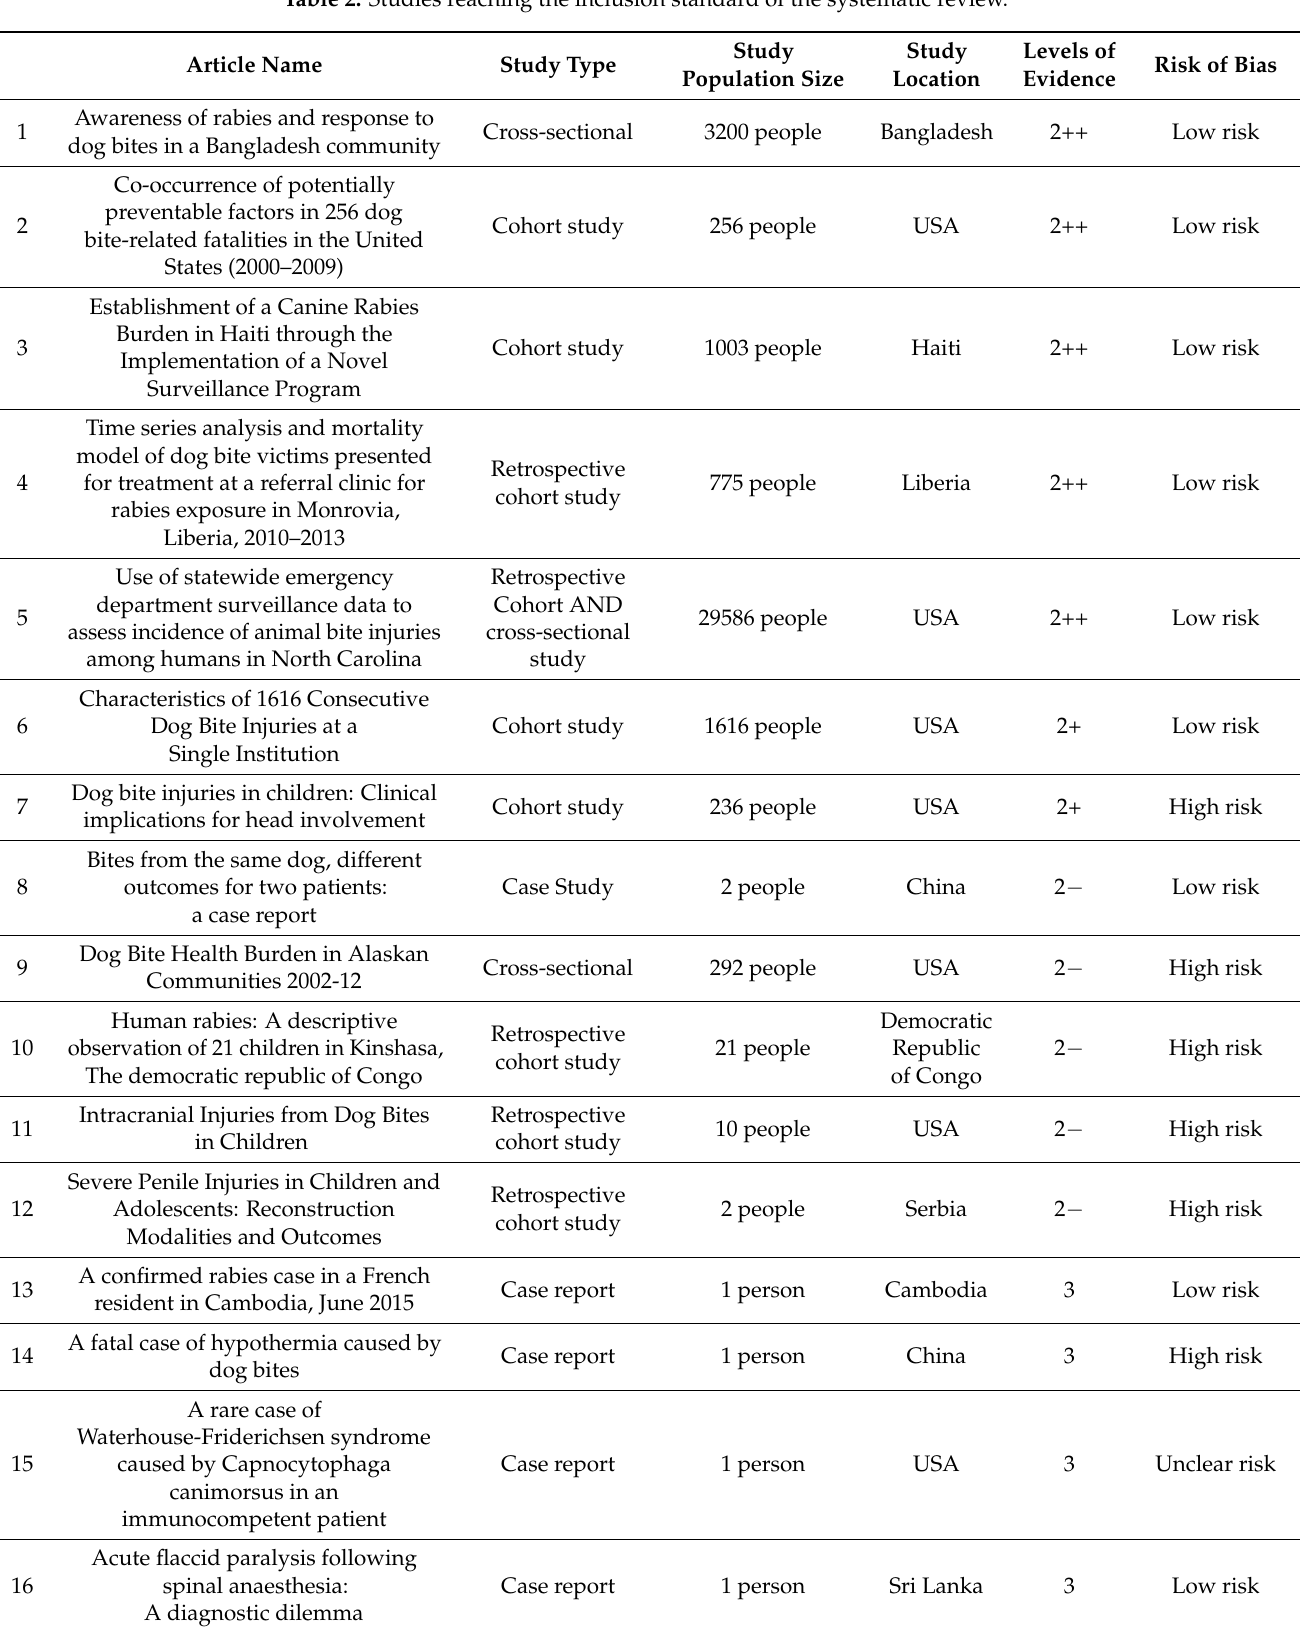
Table 2. Studies reaching the inclusion standard of the systematic